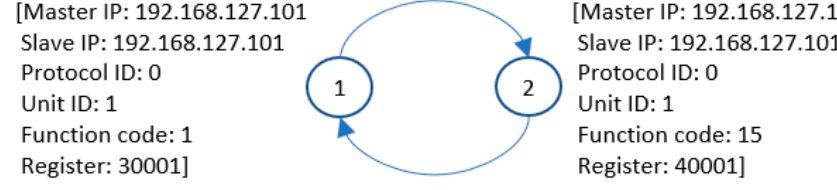
Figure 10. Example—communication model.